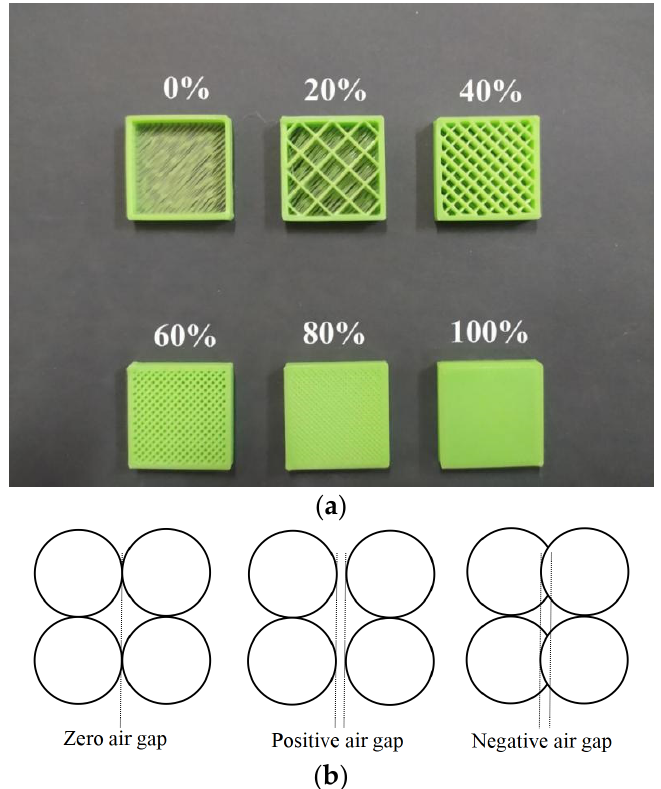
Figure 4. ( a ) infill percentage, and ( b ) schematic illustrations of an air gap in FFF-processed material.